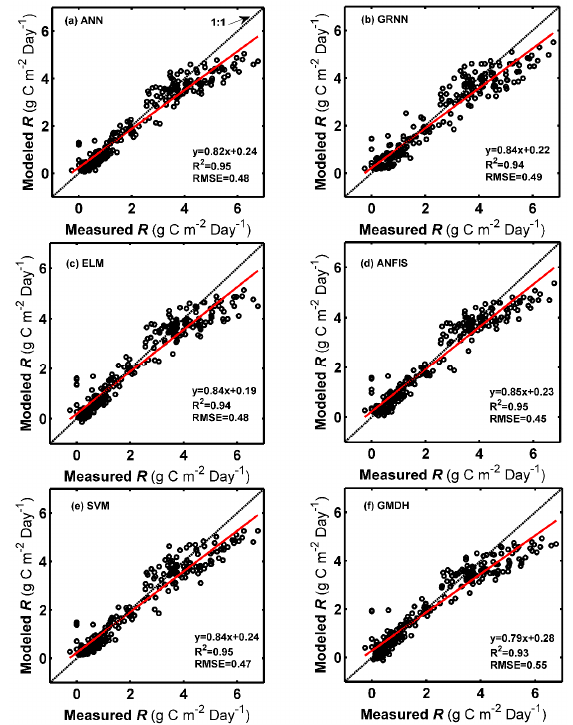
Figure 5. Comparisons of daily R measured by eddy covariance technique and predicted by data-driven models for the testing period. ( a ) ANN model; ( b ) GRNN model; ( c ) ELM model; ( d ) ANFIS model; ( e ) SVM model; and ( f ) GMDH model.